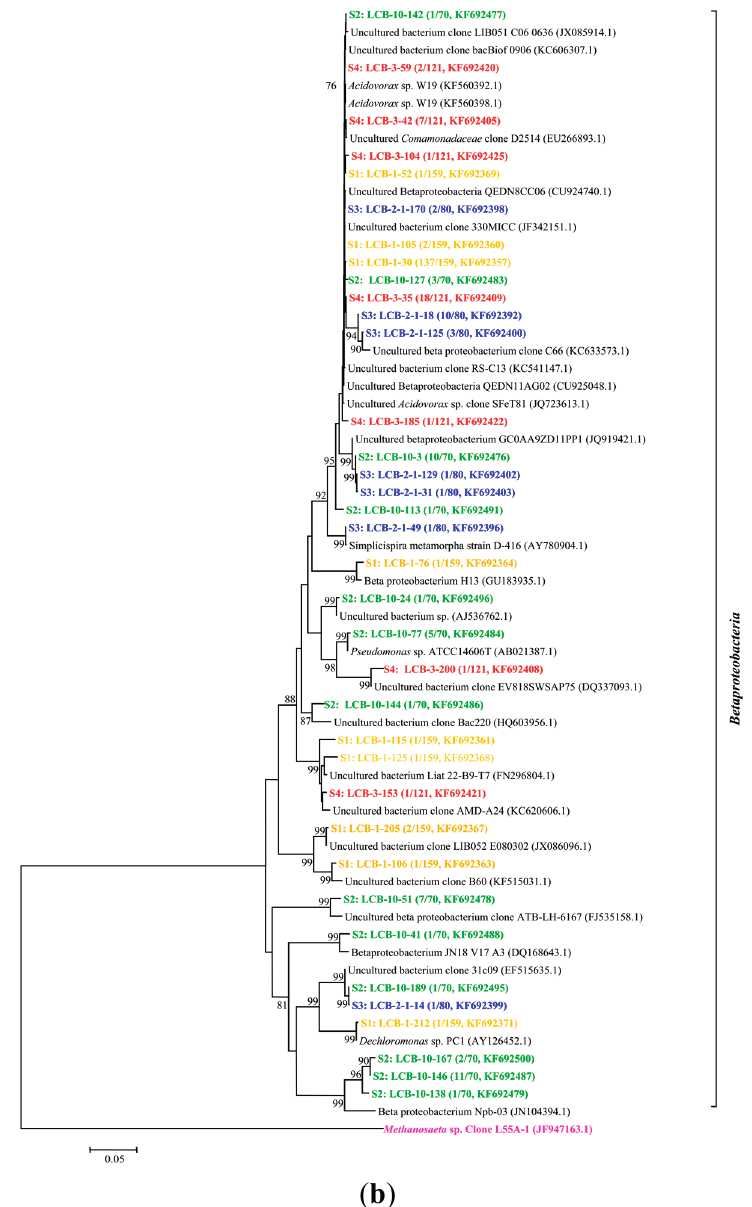
Figure 2. ( a ) Phylogenetic tree of bacterial 16S rRNA gene clones retrieved from four samples showing the distributions of OTUs and closely related sequences from GenBank database. The bootstrap values at the nodes of ≥ 75% ( n = 1000 replicates) are reported. The scale bar represents 5% sequence divergence. The numbers in parentheses indicate the frequencies of appearance of identical clones in the total analyzed clones followed the accession number in GenBank. Methanosaeta sp. clone was used as outgroup; ( b ) Phylogenetic tree of bacterial 16S rRNA gene clones retrieved from samples showing the distributions of OTUs and closely related sequences from GenBank database. The bootstrap values at the nodes of ≥ 75% ( n = 1000 replicates) are reported. The scale bar represents 5% sequences divergence. The numbers in parentheses indicate the frequencies of appearance of identical clones in the total analyzed clones followed the accession number in GenBank. The Methanosaeta sp. clone was used as outgroup. The gene sequences from different samples are assigned with different colors: S1 in yellow, S2 in green, S3 in blue and S4 in